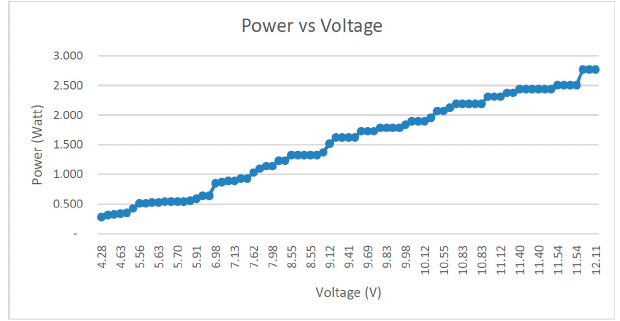
Figure 8. Graph of power vs. voltage of controlled state.